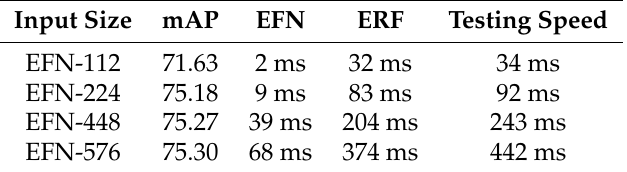
Table 4. Accuracy and average testing speed comparison between different input sizes of EFN.